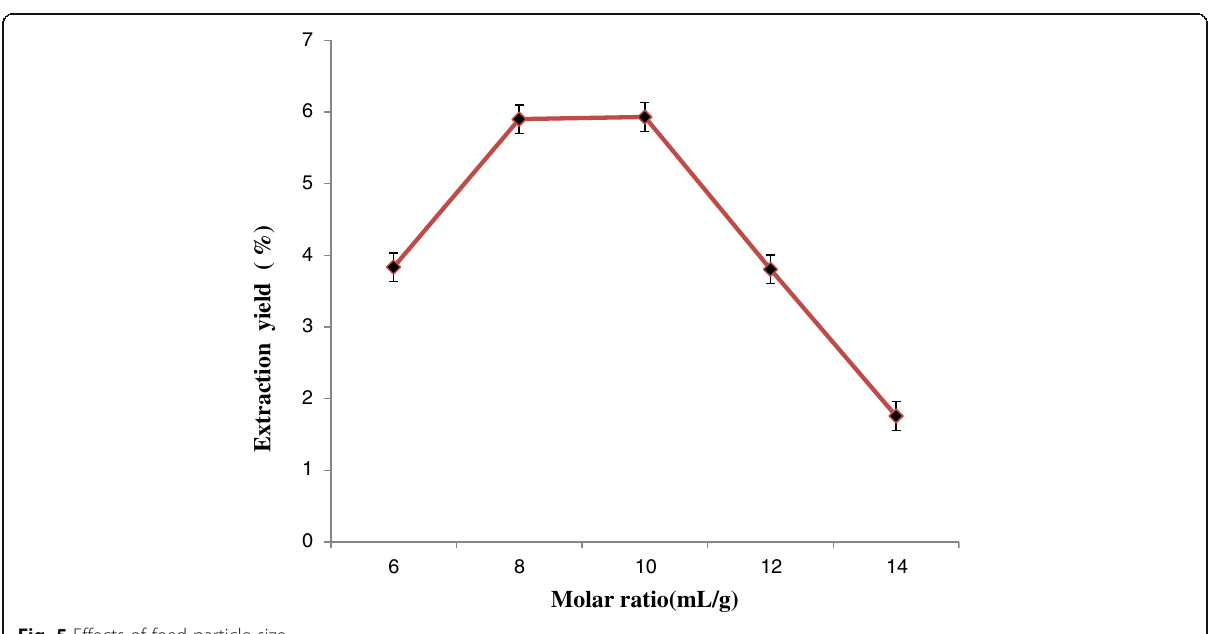
Fig. 5 Effects of feed particle size